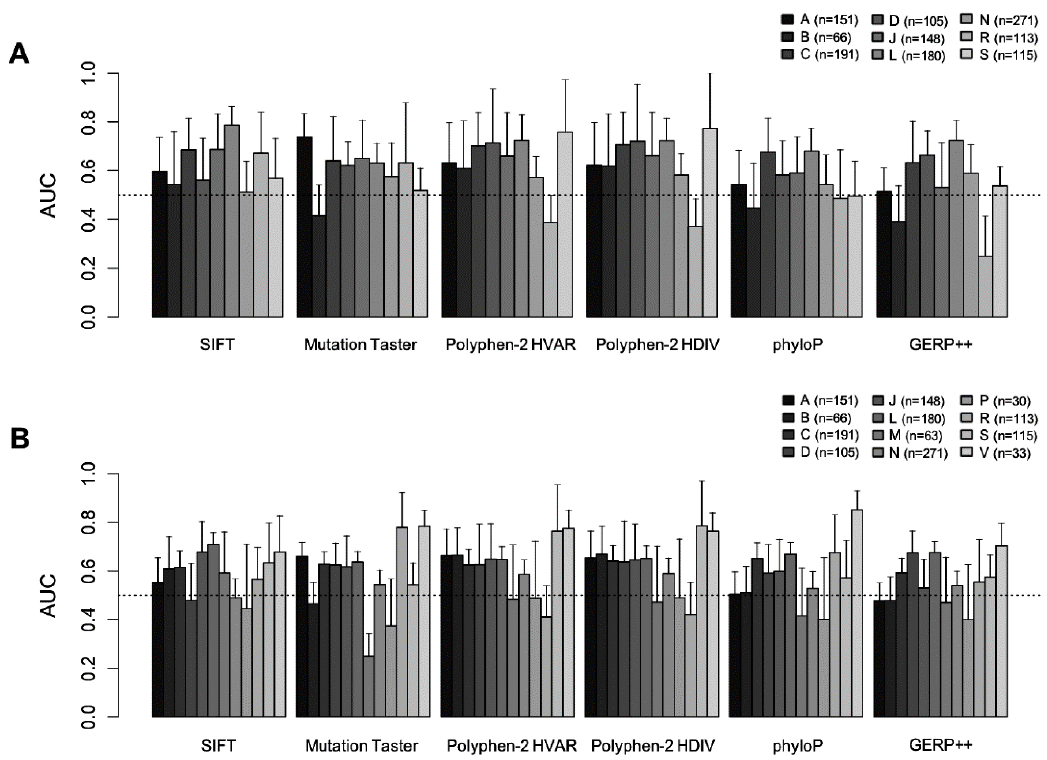
Figure 5. Comparison of the drug-level GVB prediction accuracies for variant-drug associations in PharmGKB across different anatomical main groups of drugs, using six different in silico methods. The AUCs for the ( A ) ethnicity-specific and ( B ) ethnicity-non-specific evaluations across the 14 anatomical main groups using six different in silico methods (i.e., SIFT, MutationTaster, PolyPhen-2 HVAR, PolyPhen-2 HDIV, phyloP, and GERP ++ ). The dotted line represents the reference line (AUC = 0.5). GVB SIFT exhibited robust performance across all the ATC classes, especially in the ethnicity-specific validations (all AUCs > 0.5 and AUC = 0.7862 for antineoplastic and immunomodulating agents (class [L], n = 180), respectively). Classes G and H were excluded due to the lack of variant-drug association (VDA) in PharmGKB and classes M, P, and V (A) due to the lack of ethnicity-specific VDA information in PharmGKB. AUC: area under the receiver operating characteristics curve.